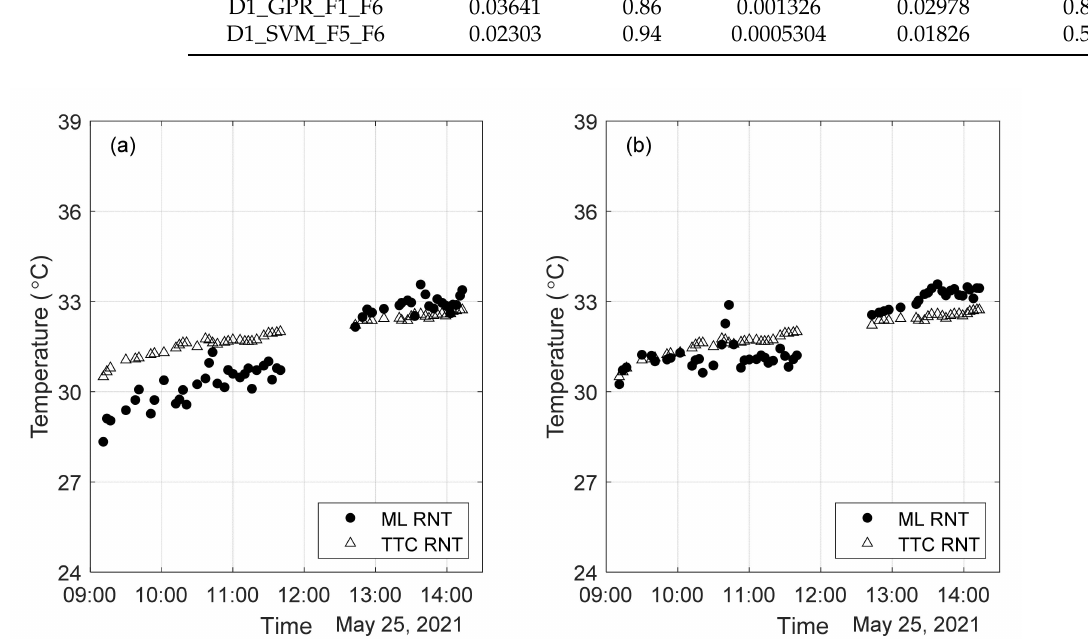
Figure 21. Testing the D1 on empirical data D2. RNT vs. Temperature for: ( a ) F1 through F6 Input; ( b ) F5 and F6